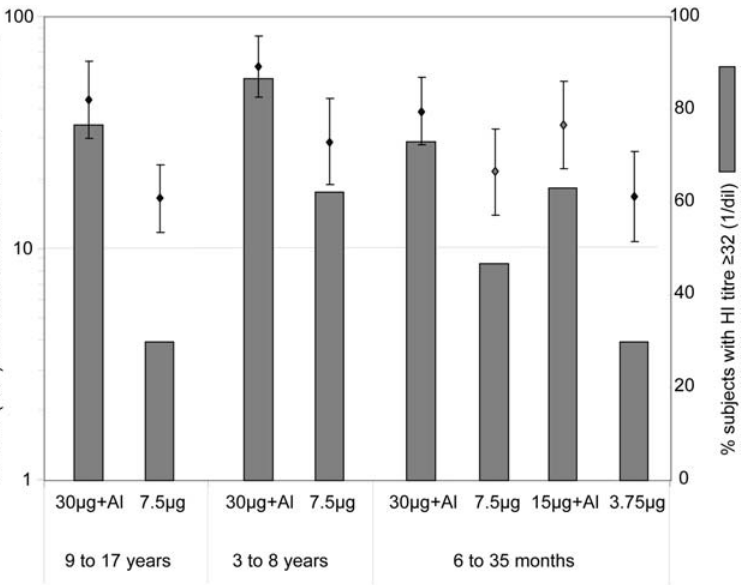
Figure 1. Haemagglutination inhibition antibody response 21 days after two injections, 21 days apart of adjuvanted or non- adjuvanted H5N1 vaccine. Results are presented per age and vaccine formulation group as geometric mean titres (GMT) and the proportion of subjects with titres $ 32.